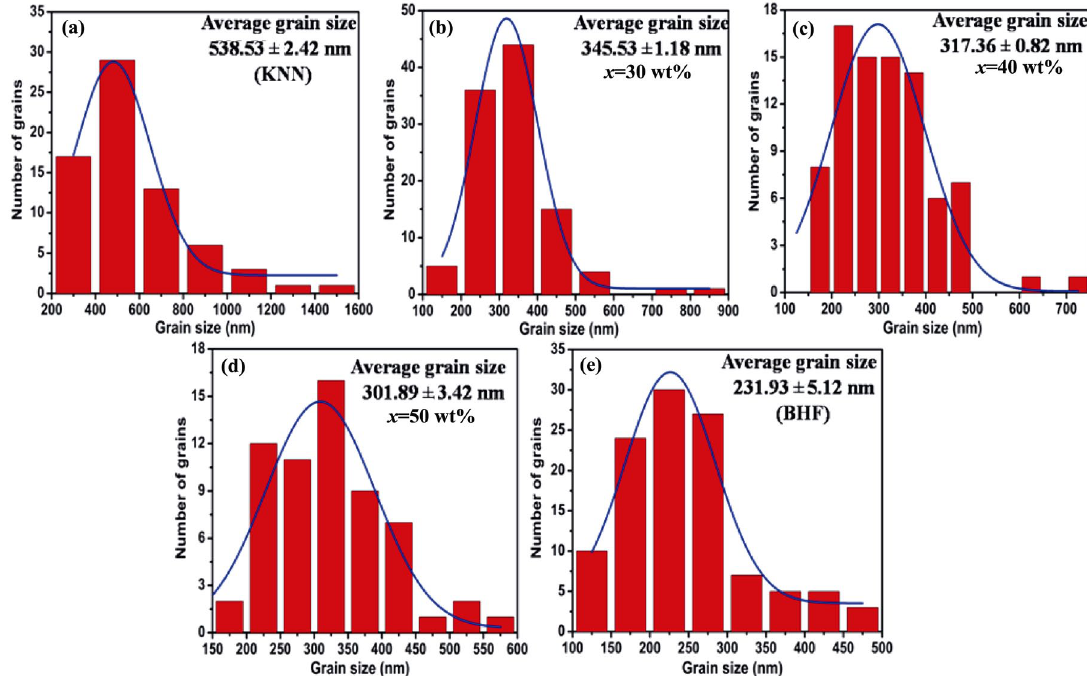
Fig. 3 Log normal distribution of grain size of (1 ̶ x )KNN–( x )BHF composites: (a) KNN, (b) x = 30 wt%, (c) x = 40 wt%, (d) x = 50 wt%, and (e) BHF. The insets represent the average grain sizes